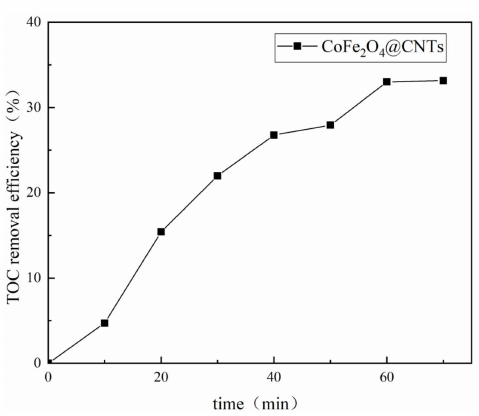
Figure 12. The effectiveness of TOC removal in the CoFe 2 O 4 @CNTs/PMS/CQP system.